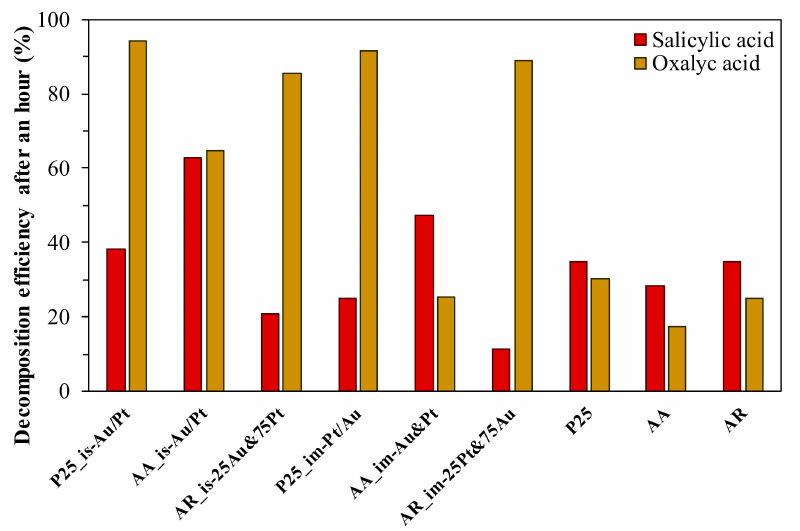
Figure 10. Comparison of the degradation of oxalic acid and salicylic acid of the samples—generally, the P25 and AR-based composites had higher activity for oxalic acid degradation than for salicylic